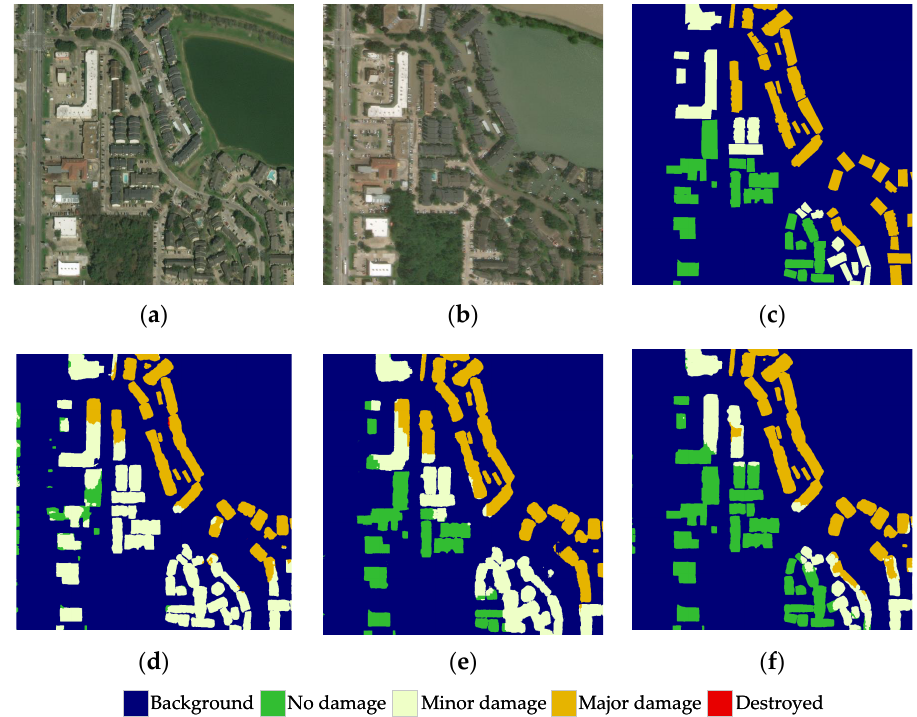
Figure 8. The visual comparison of prediction results on hurricane–Harveyan xBD dataset. ( a ) Pre- disaster; ( b ) post-disaster; ( c ) ground truth; ( d ) baseline; ( e ) SDAFormer (without SF); ( f ) SDAFormer (with SF).